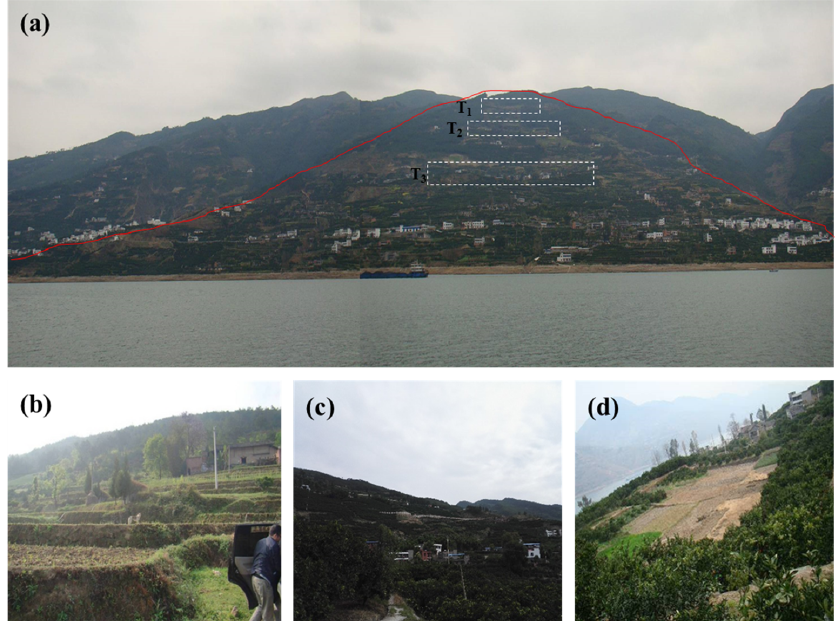
Figure 9. Photographs of the Xinpu landslide showing ( a ) front view, ( b ) Daping landslide terrace (T 1 ), ( c ) Shangertai landslide terrace (T 2 ) and ( d ) Xiaertai landslide terrace (T 3 ).